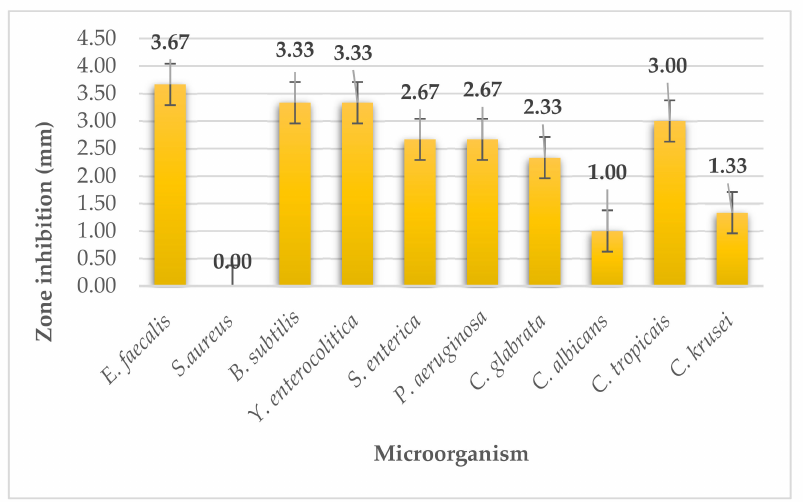
Figure 9. Antimicrobial activity of